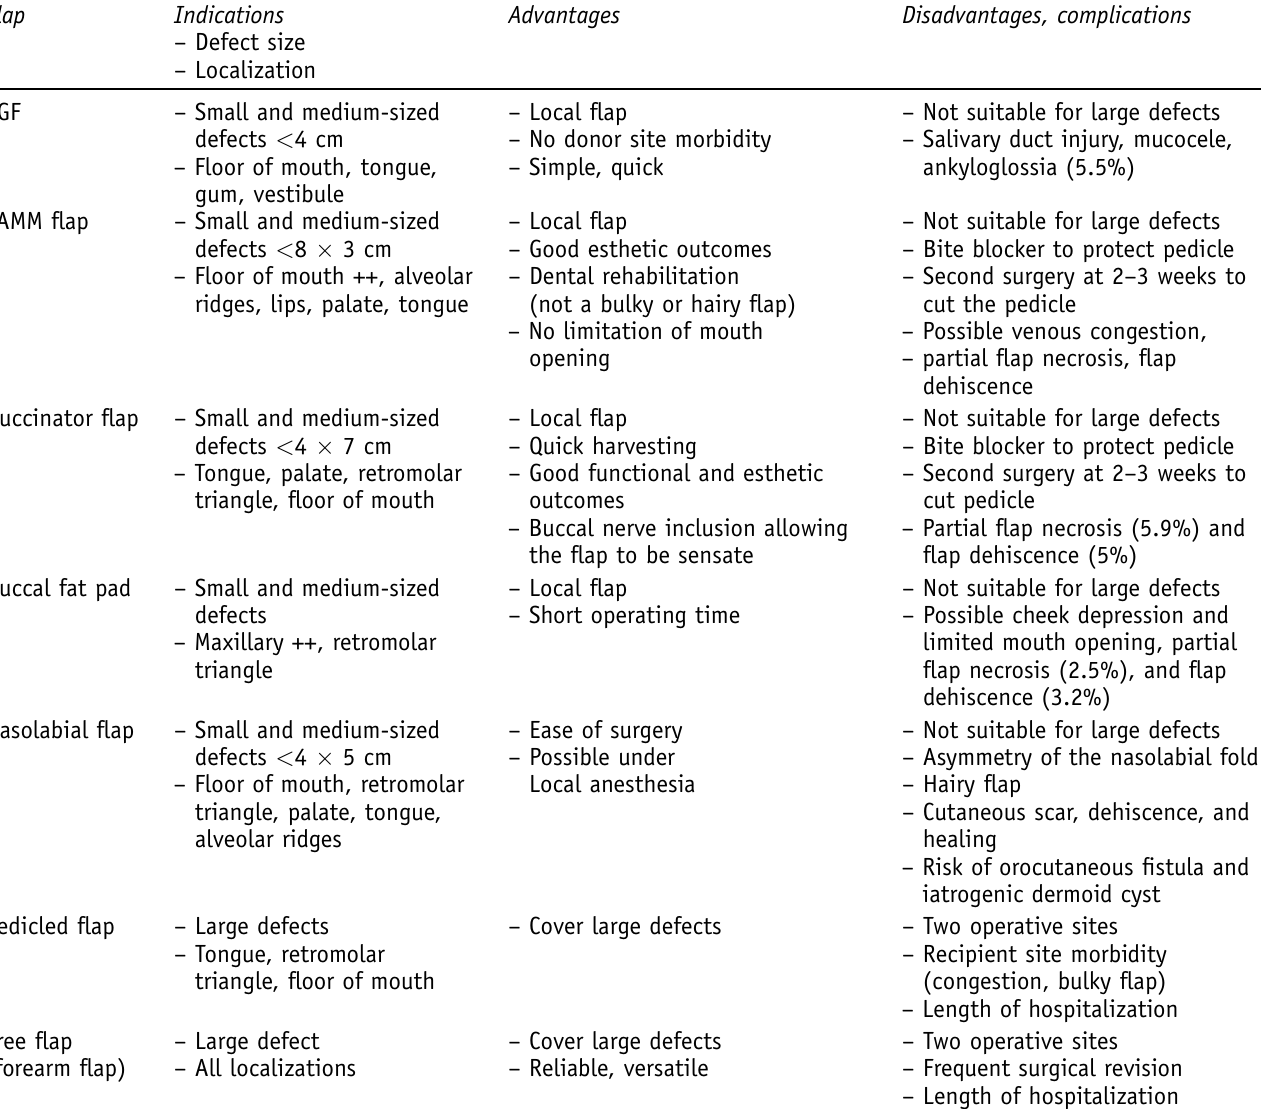
Table I. Advantages and disadvantages of available fl aps for the reconstruction of defects of the oral mucosa. SGF, sublingual gland fl ap; FAMM, facial artery